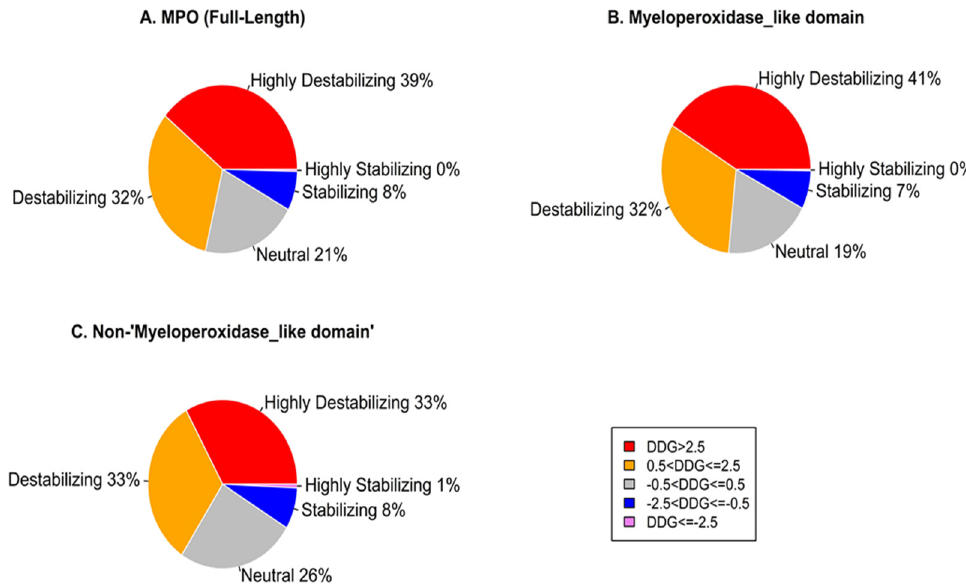
Figure 1. Distribution of the effects of missense mutations on MPO stability. ( A ) residues 167 − 744 of the whole sequence of 1CXP.pdb; ( B ) residues 317 − 728 of the Myeloperoxidase_like domain; ( C ) residues 167 − 315 & 729 − 744 outside the Myeloperoxidase_like